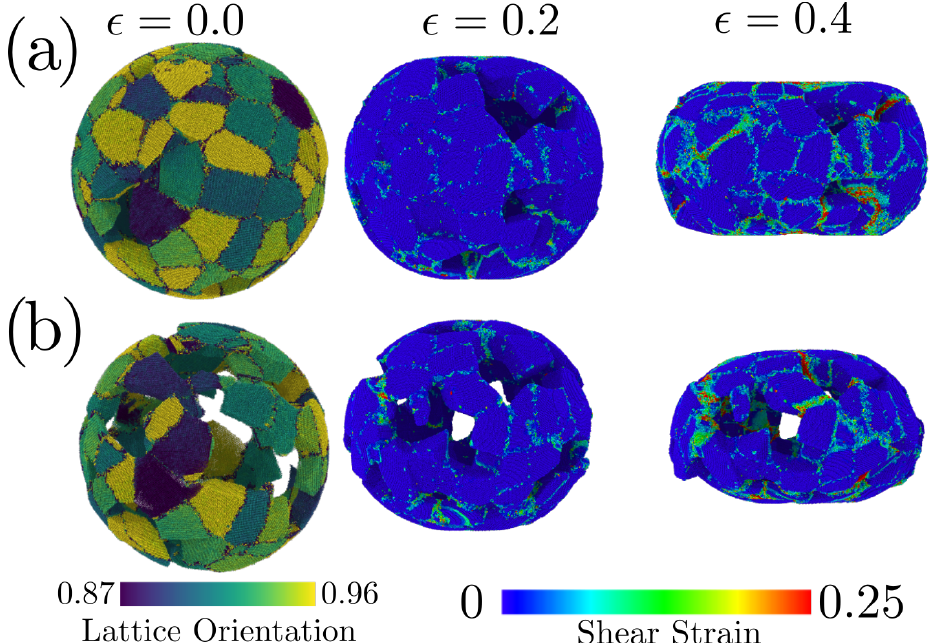
Figure 8. ( a ) Shear strain of a porous NS with φ = 0.11. ( b ) Shear strain of porous NS of φ = 0.403. To depict the grain boundary structure, we use as refence the case of (cid:101) = 0.0, where both NS are colored according to their lattice orientation, calculated from the PTM